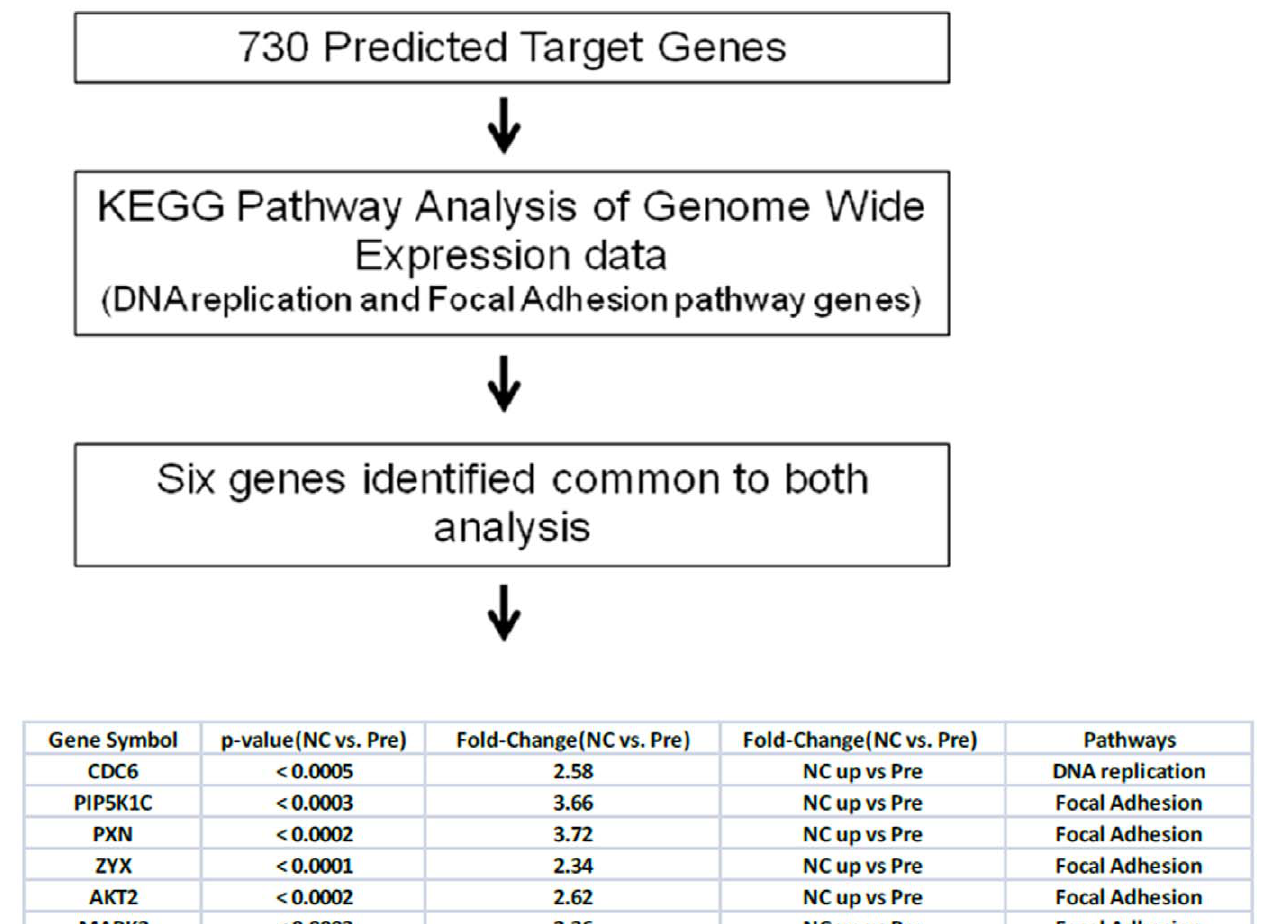
Figure 3. Work flow of integrated genomic analysis of miR-886-3p target genes and pathways.